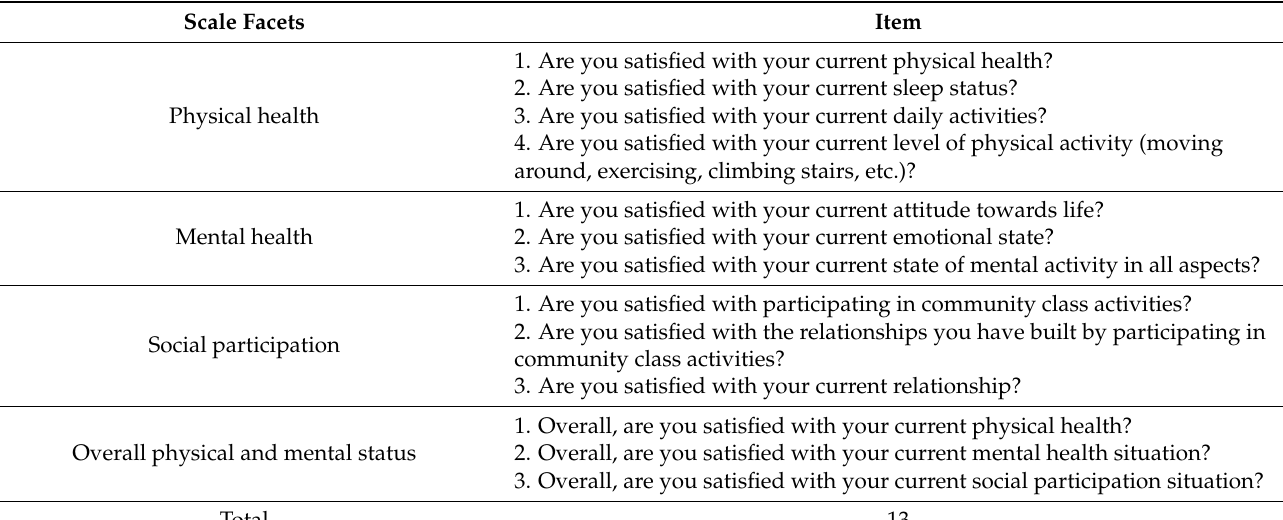
Table 1. Physical and mental health scale for middle-aged and elderly people. Scale